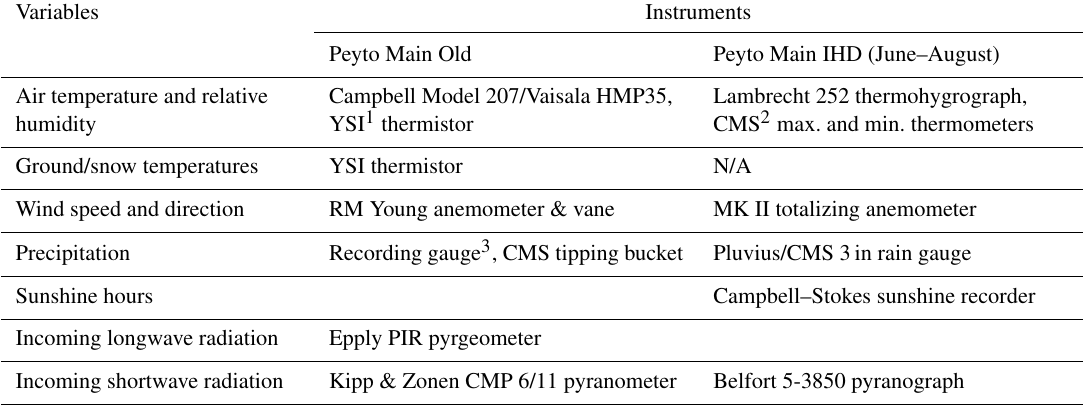
Table 2. Details of hourly PGRB meteorological data referred to in Goodison (1972) and Munro (2011b). N/A indicates “not available”.